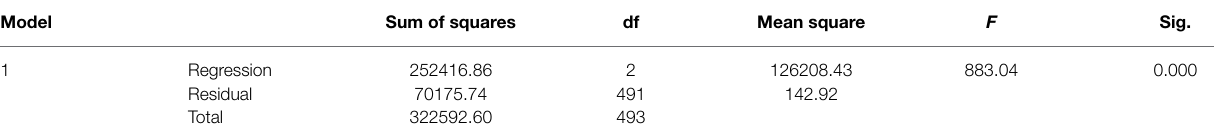
TABLE 6 | Coefficients for teachers’ ambiguity tolerance, enthusiasm, and burnout.